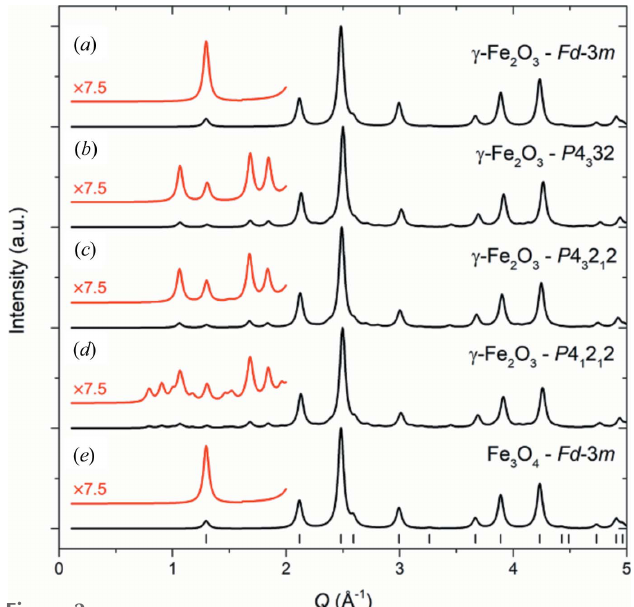
Figure 2 Simulated PXRD patterns for 15 nm nanocrystallites of (cid:2) -Fe 2 O 3 (space groups: Fd (cid:2) 33 m , P 4 3 32, P 4 3 2 1 2 and P 4 1 2 1 2) and Fe 3 O 4 (space group: Fd (cid:2) 33 m ). The additional superstructure reflections in the low Q region arising from the ordering of vacancies in the structure are magnified and illustrated in red.